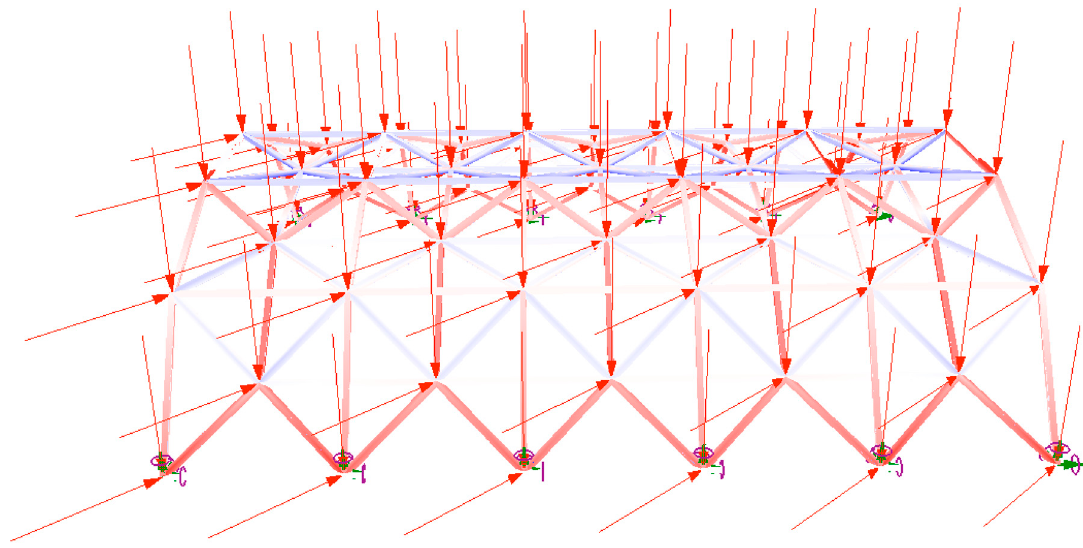
Figure 11. Evaluation of the structure model.